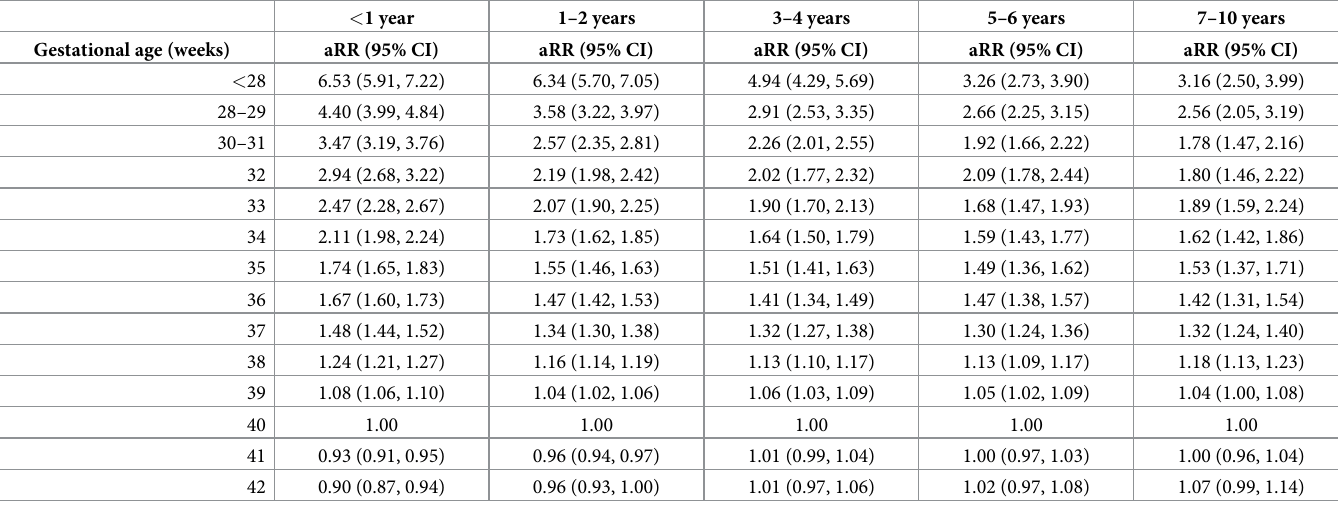
(51,644) were gastro-intestinal infections; 1.6% (8,058) were invasive bacterial infections; 4.5% Table 3. Adjusted � rate ratios and 95% confidence intervals for infection-related hospital admissions, by gestational age at birth and age at